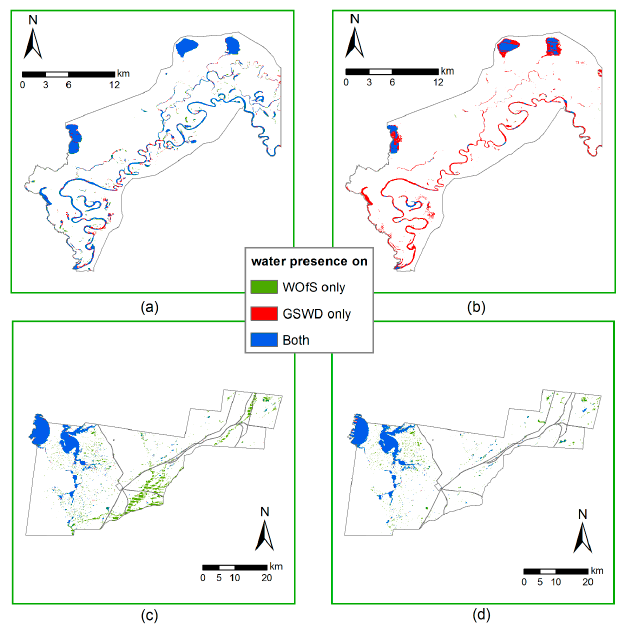
Figure 11. Differences of monthly maximum water observation in WOfS and GSWD at ( a ) Riverland with high flow (November 2010), ( b ) Riverland with low flow (August 2010), ( c ) Currawinya Lakes with high flow (December 2010), ( d ) Currawinya Lakes with low flow (September 2010).